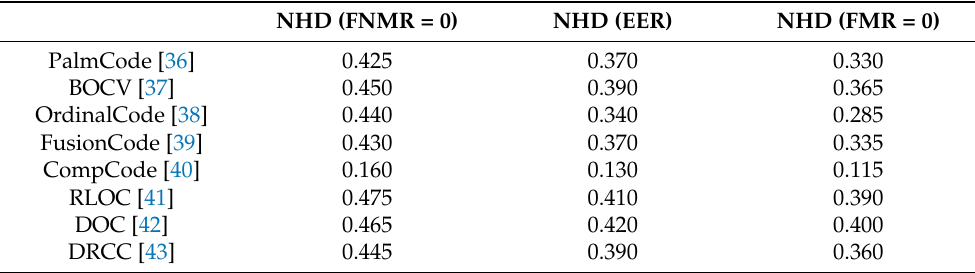
Table 2. Normalized Hamming distances at EER, FNMR = 0, and FMR = 0 on PalmBigDatabaseA. NHD (FNMR =